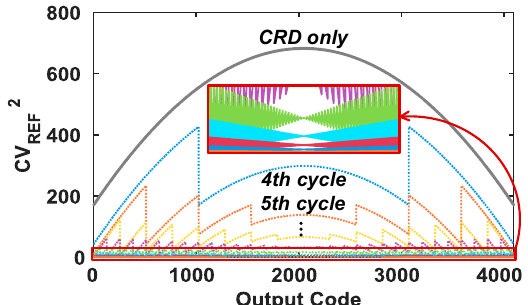
Figure 5. The switching energy for the CRD according to the RSC.